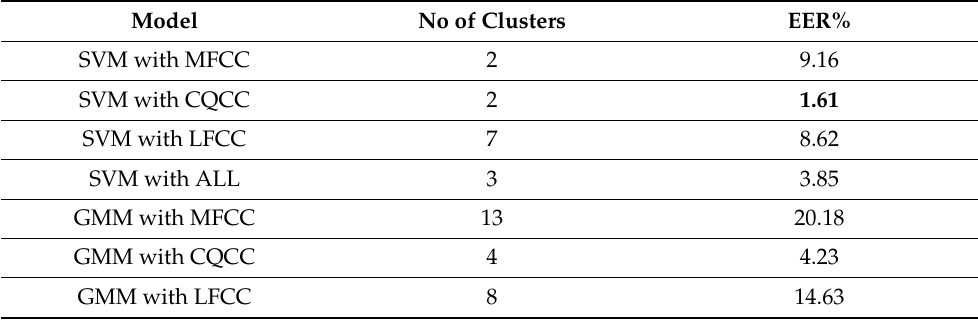
Table 5. Best performance achieved by each combination of feature/classifier for the optimal number of partitions on the ASVspoof 2017 benchmark